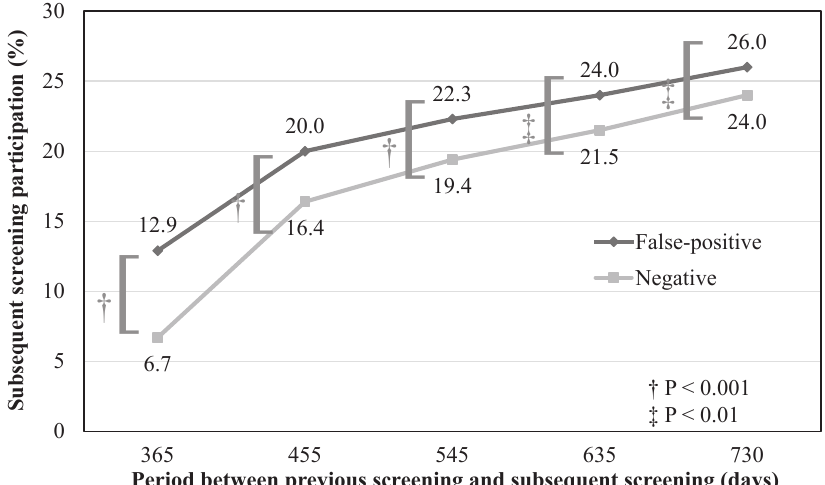
Period between previous screening and subsequent screening (days) Figure 3. Sensitivity analysis of subsequent participation in lung cancer screening. The proportion of participants with subsequent screening participation was consistently higher in participants with false-positive results compared to those with negative results, even when the duration of the period between primary screening and subsequent screening was extended. However, the di ff erences in proportions of participants with subsequent screening participation were reduced as longer durations were applied.